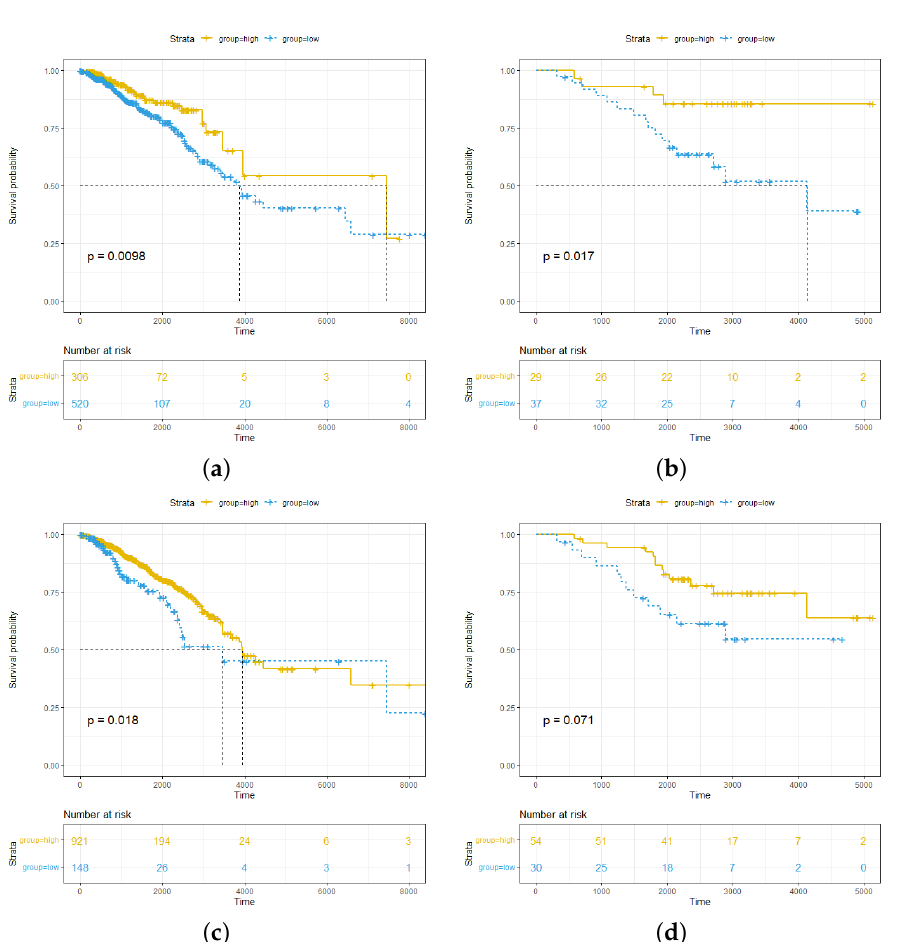
Figure 1. Correlation between clinical outcome and pDC or cDC abundance in breast cancer patients. ( a ) The Kaplan–Meier curves of breast cancer patients showed that patients with a high